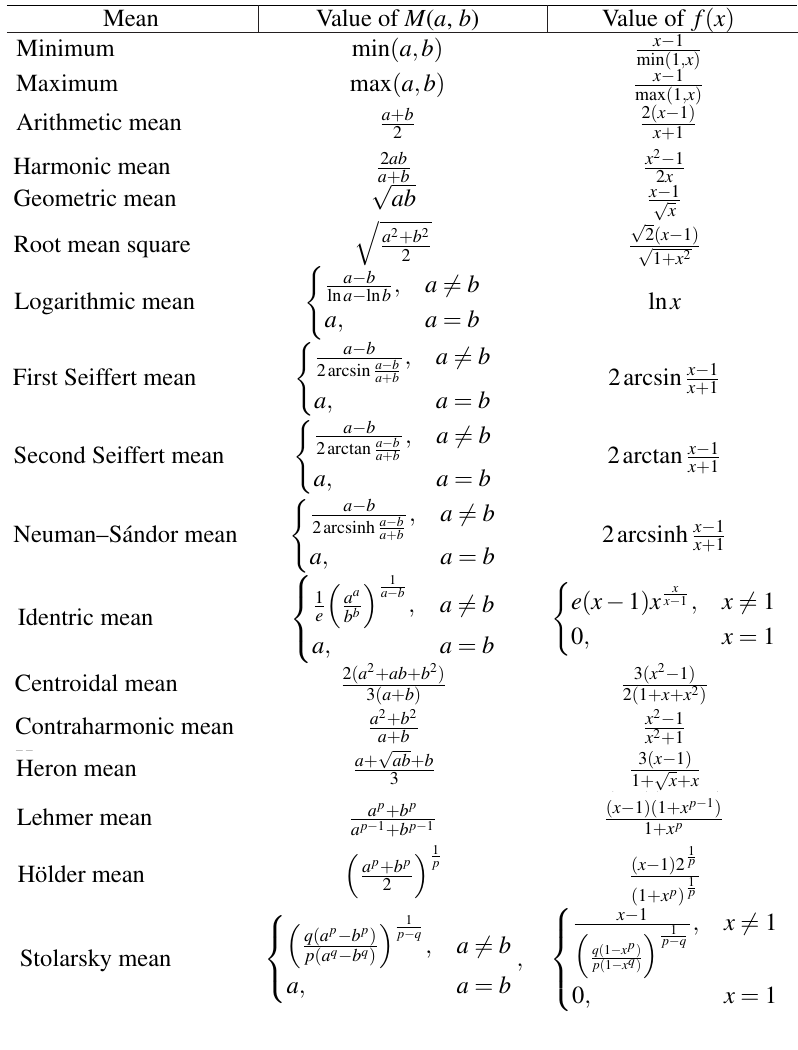
Table 1. Maps f for different means